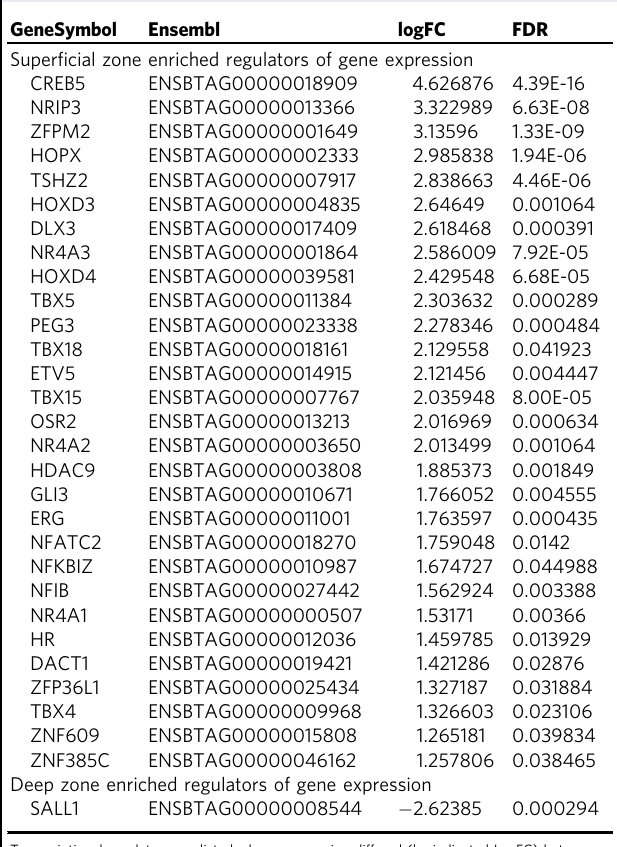
Table 1 Differentially expressed regulators of gene